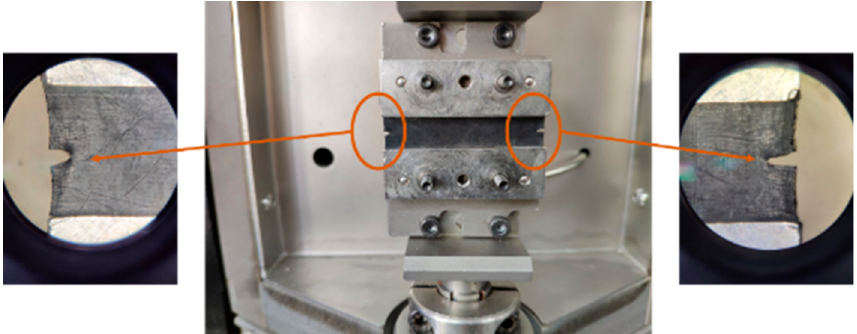
Figure 4. The crack tip and fatigue crack growth test specimen (length 40 mm, width 6 mm, thickness 2 mm, pre-cut 1.5 2 mm, pre-cut 1.5 mm).